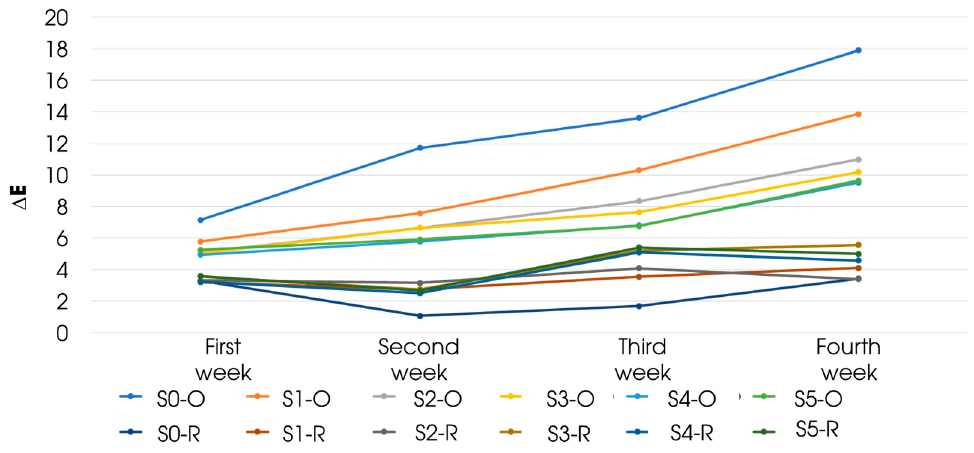
Figure 9. The time-varying color of aqueous solutions of the extract at room temperature and at 45 °C.